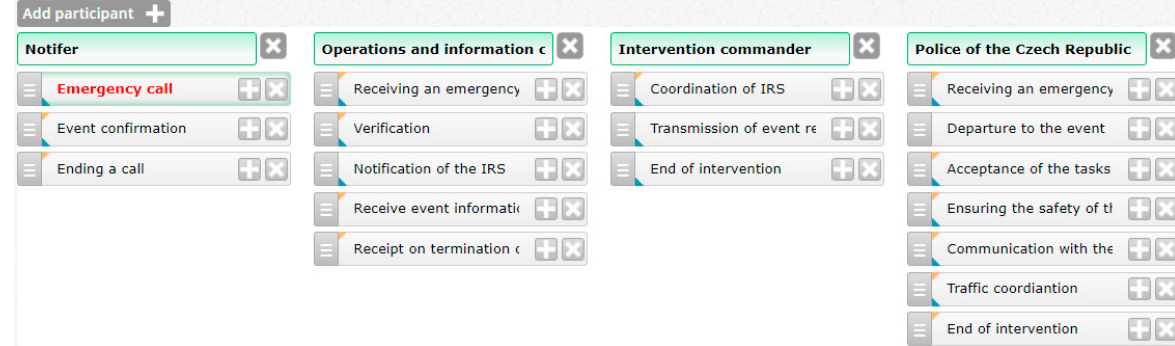
Figure 4. Tabular view.